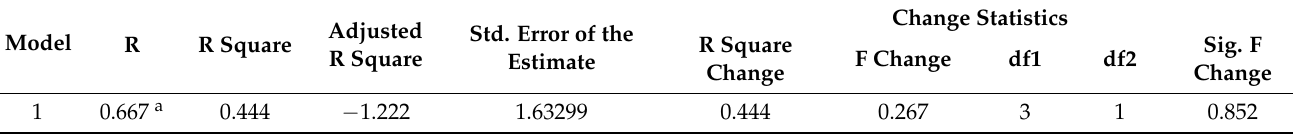
Table 8. Model Summary—Usage of outdoor charging solutions and obstacles found. Model